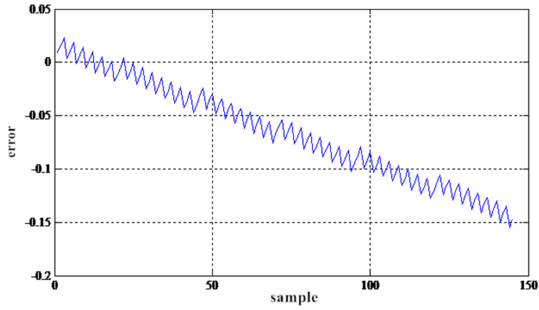
Figure 4. Charging time estimate error